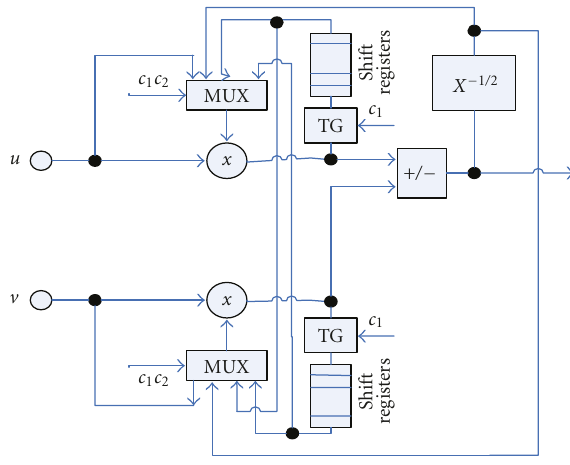
Figure 12: The structure of the generic PE for unified architectures for parametric transform synthesis and